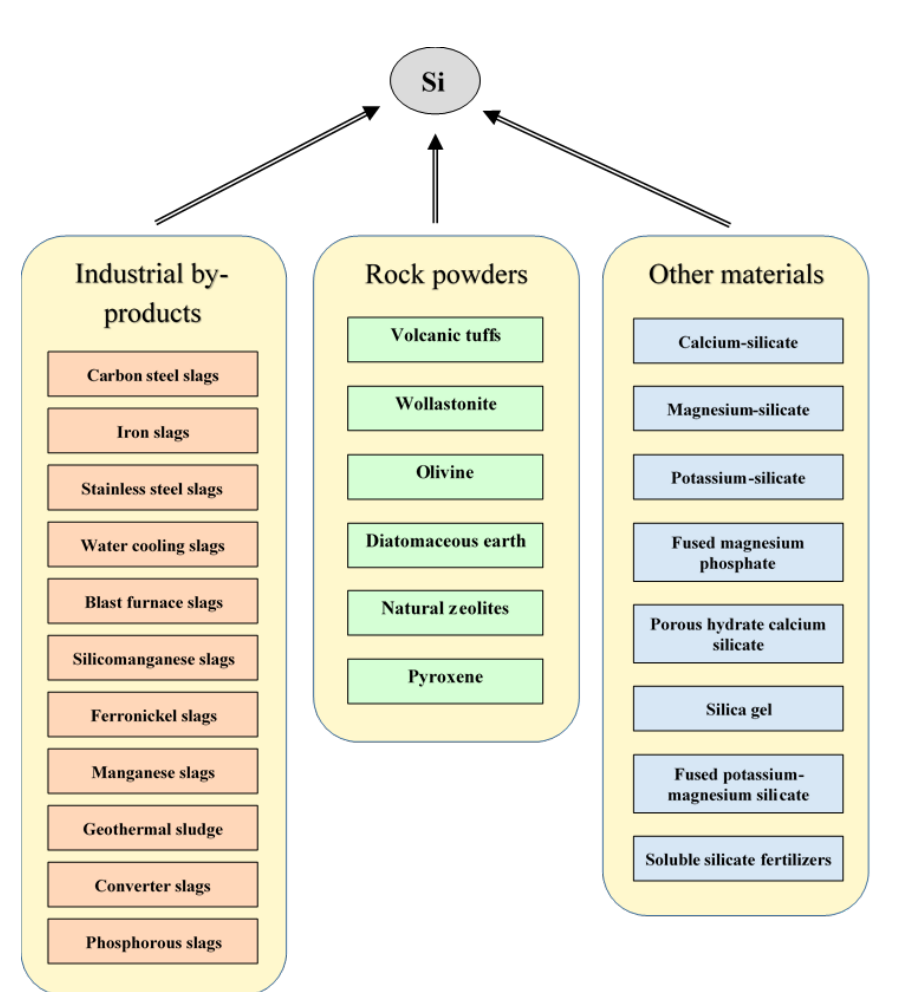
Figure 4. The silicon-containing materials, originated from various organic and inorganic sources, usable as fertilizers.